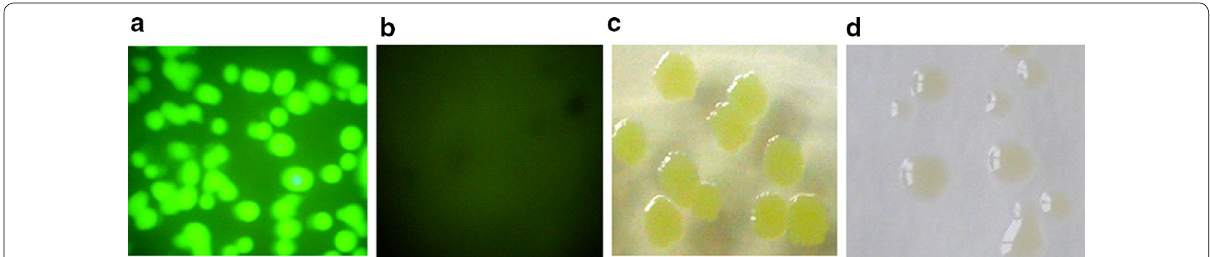
Fig. 3 Images of BL21AI‑GBS. a , b Colonies of BL21AI‑GBS ( a ) and E. coli BL21AI TM ( b ) on LB agar plates photographed by a fluorescent microscope (magnification: 10 4); c , d colonies of BL21AI‑GBS ( c ) and E. coli BL21AI TM ( d ) on LB agar plates photographed directly in ×